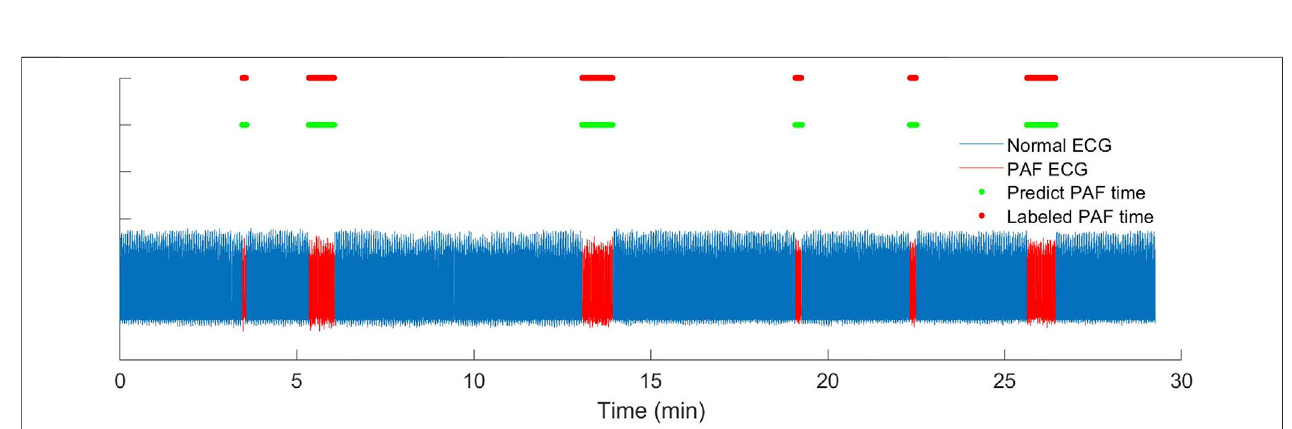
FIGURE 9 | The rhythm recheck result of wearable ECG segments in CPSC 2021